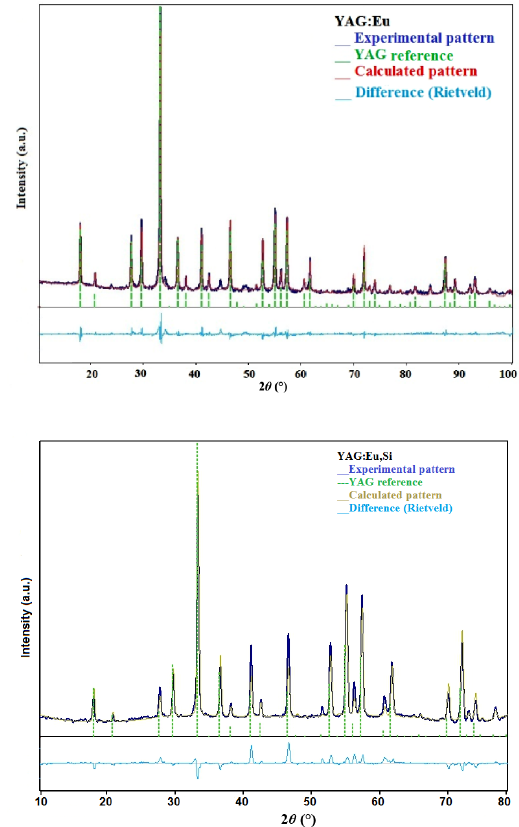
Fig. 3 Rietveld refinement for phosphors.